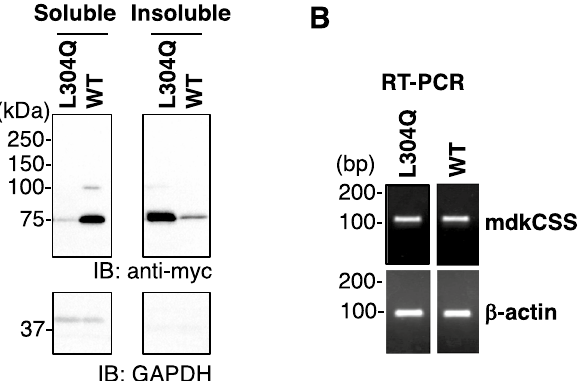
Figure 6. Property of WT and L304Q mdkCSS expressed in CHO cells. ( A ) Distribution of mdkCSS in the soluble and insoluble fractions. The myc-tagged WT and L304Q mdkCSS were transiently expressed in CHO cells, and their homogenates were separated into the soluble and insoluble fractions by the high speed centrifugation, followed by western blotting with the anti-myc antibody. Immunostaining with anti-GAPDH was performed as the loading control for soluble fraction. Note that the GAPDH bands were not detected in the insoluble fraction, which is reasonable because that GAPDH is a soluble protein. The band at 75 kDa stands for mdkCSS. ( B ) Expression level of the mRNA for mdkCSS. The transfected CHO cells expressing the myc-tagged WT and L304Q mdkCSS were analyzed by RT-PCR using the specific primers. The expression level of β-actin was used as the loading control. Full-length blots/gels for A and B are presented in Supp_FigS12 and Supp_ FigS13, respectively.